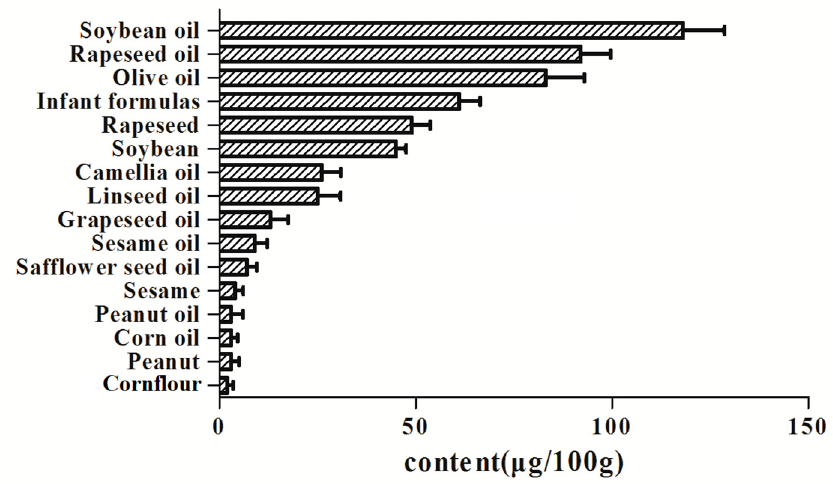
Figure 5. Vitamin K 1 content in fat-containing foods.